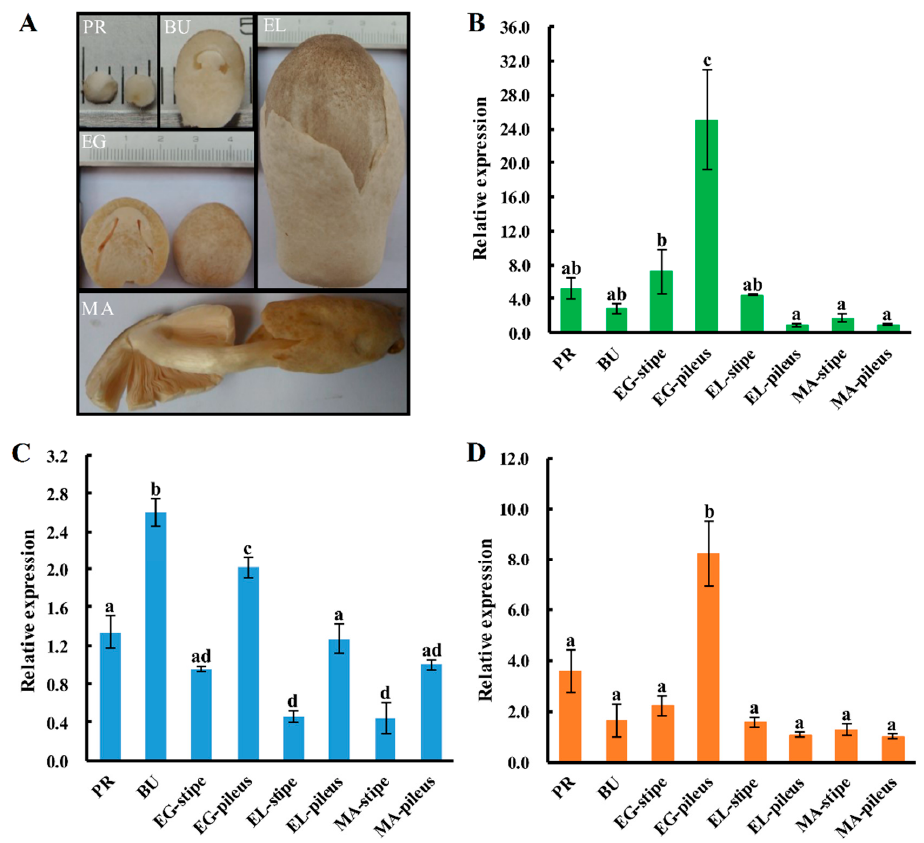
Figure 5. Expression patterns of sod genes in different tissues during different developmental stages of V. volvacea H1521. ( A ) the different fruiting body growth stages of V. volvacea ; ( B ) the differential expression pattern of Cu-Znsod1 gene; ( C ) the differential expression pattern of Mnsod1 gene; and ( D ) the differential expression pattern of Mnsod2 gene. PR = primordia; BU = button stage; EG = egg stage; EL = elongation stage; MA = maturation stage. The gene expression levels are presented relative to that in the MA-pileus. The means of three independent experiments are shown. The error bars show the standard error of the mean, and the different letters over the columns within a graph denote significant differences ( p < 0.05, LSD test, n = 3).